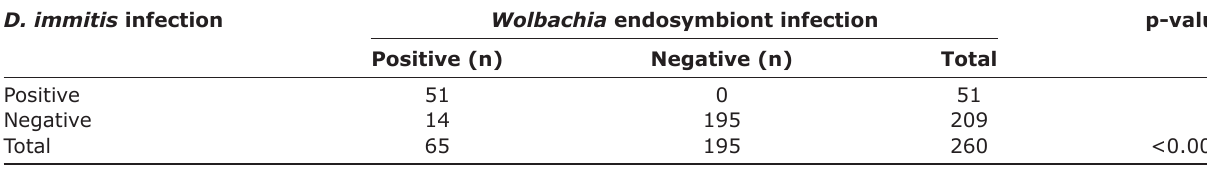
Table-3: Association between D. immitis and Wolbachia endosymbiont infections in all cats. D. immitis